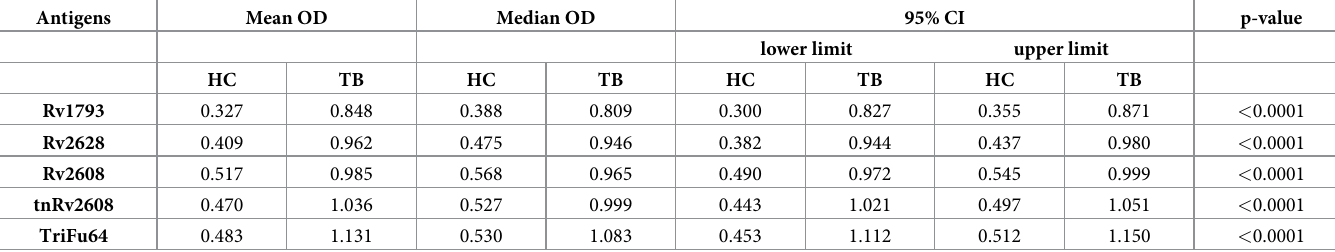
Table 3. Descriptive statistics of one-way ANOVA performed on ELISA results of Mtb antigens against healthy controls (HC) and TB patients (TB). Antigens Mean OD Median